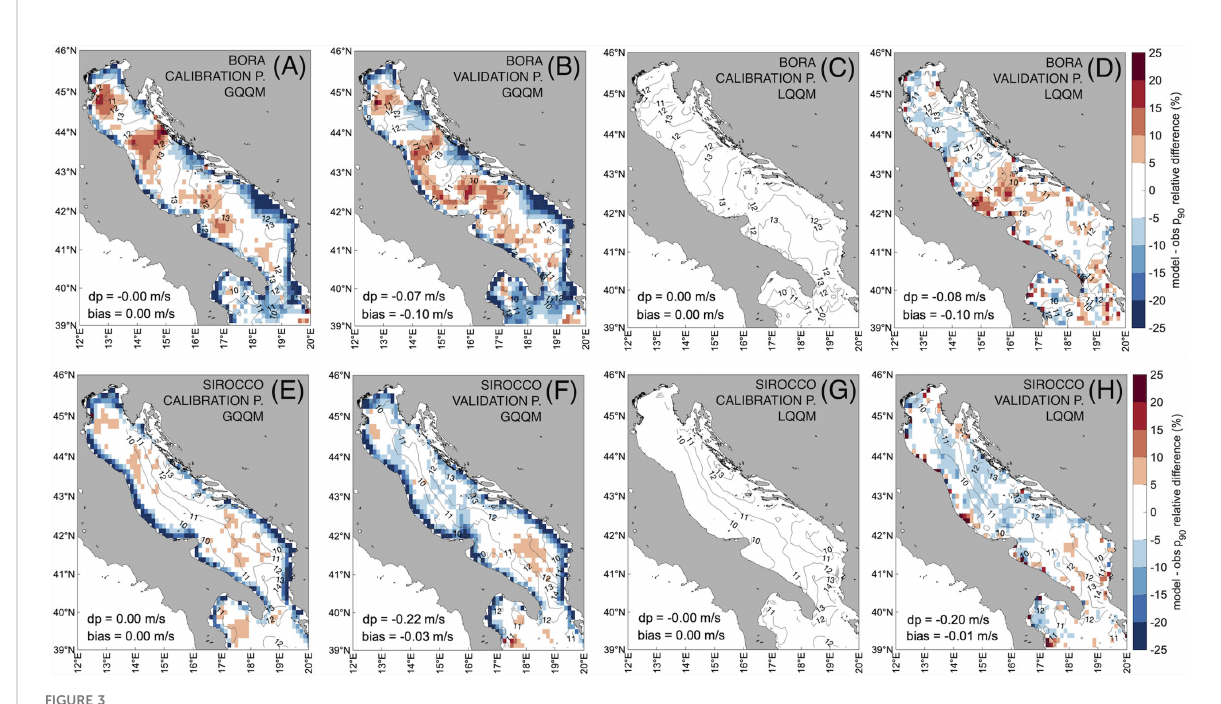
FIGURE 3 Comparison of wind forcing calibration strategies GQQM (A, B, E, F) and LQQM (C, D, G, H) , during the calibration (A, C, E, G) and validation (B, D, F, H) periods, for Bora (A – D) and Sirocco (E – H) . Model-observation 90 th percentile relative difference (%) over the Adriatic and Ionian Seas. dp is the difference of the ensemble 90 th percentile, bias is the mean model-observation difference of all the data. Contour lines are the observed wind speed 90 th percentiles